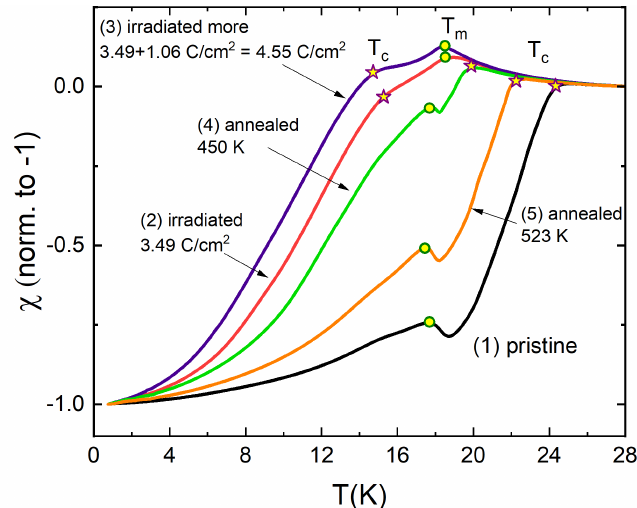
Figure 5. Electron irradiation and subsequent annealing studies of the same EuFe 2 ( As 0.77 P 0.23 ) 2 sample as shown in Figure 4. Curve (1): pristine state; (2): after 3.49 C/cm 2 irradiation; (3) 4.55 C/cm 2 total dose where 1.06 C/cm 2 was added after step (2); (4) after annealing at 450 K, and (5) after the second annealing at 523 K. Stars mark the superconducting transition and the circles mark the ferromagnetic